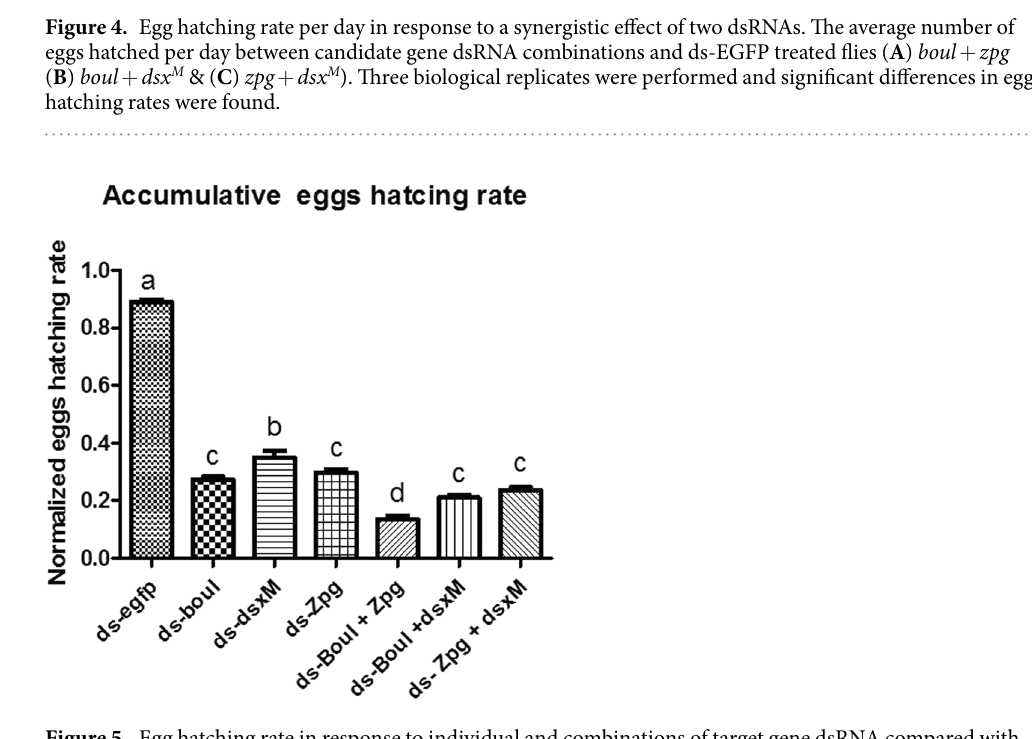
Figure 5. Egg hatching rate in response to individual and combinations of target gene dsRNA compared with ds-EGFP treated flies. Three biological replicates were performed, *** indicates significant difference. One way ANOVA indicate difference in average number of hatchings between all candidate genes dsRNA (P < 0.0001, Tukey